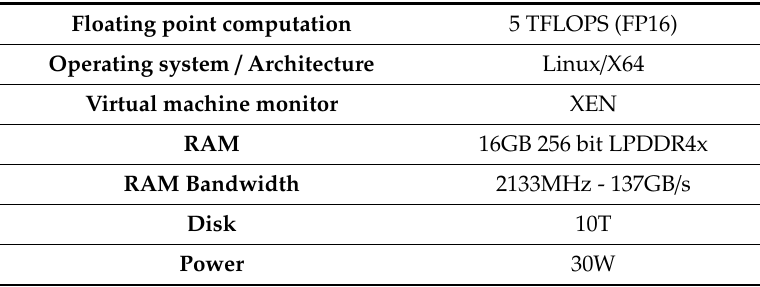
Table 4. The resource situation of each